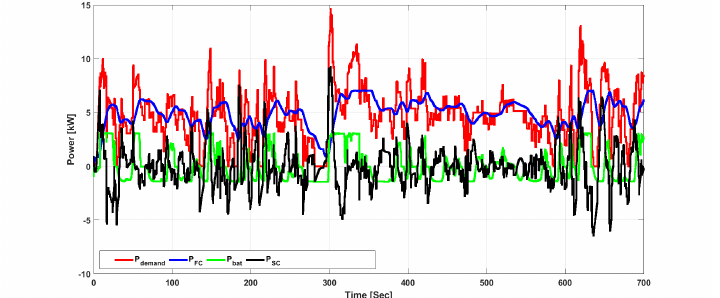
Figure 11. Power demand ( P demand ), FC power ( P FC ), battery power ( P bat ), and supercapacitor power ( P SC ) for the EMS based on FLC.